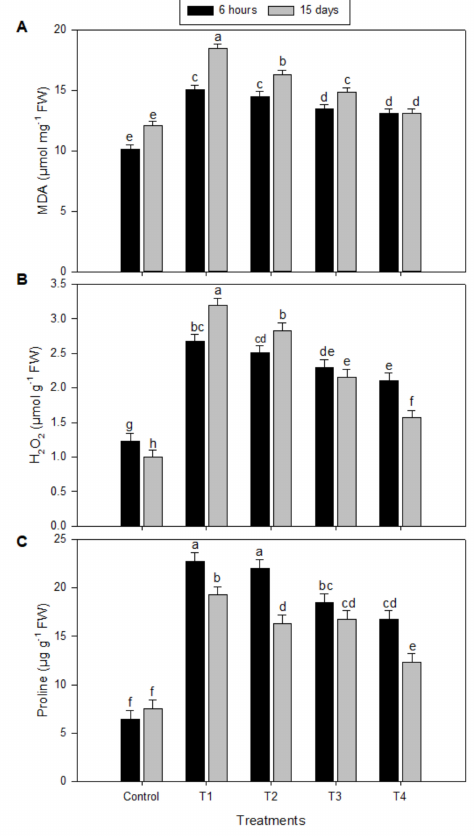
Figure 1. E ff ect of exogenous melatonin on malondialdehyde (MDA), H 2 O 2 , and proline contents ( µ mol g − 1 FW) in peanut seedlings under salinity stress after 6 h and 15 days. ( A ) Malondialdehyde (MDA), ( B ) H 2 O 2 , and ( C ) proline. Data are means ± SD ( n = 3) from three independent experiments. The bars labelled with di ff erent letters are significantly di ff erent at p ≤ 0.05. The significant di ff erence marked by di ff erent letters was calculated using the Student’s t -test and further analyzed with the Fisher LSD test, at p ≤ 0.05. The legends are as follows: Control: 0 NaCl + 0 melatonin (MT), T1: 150 mM NaCl + 0 MT, T2: 150 mM NaCl + 50 µ M MT, T3: 150 mM NaCl + 100 µ M MT, T4: 150 mM NaCl + 150 µ M